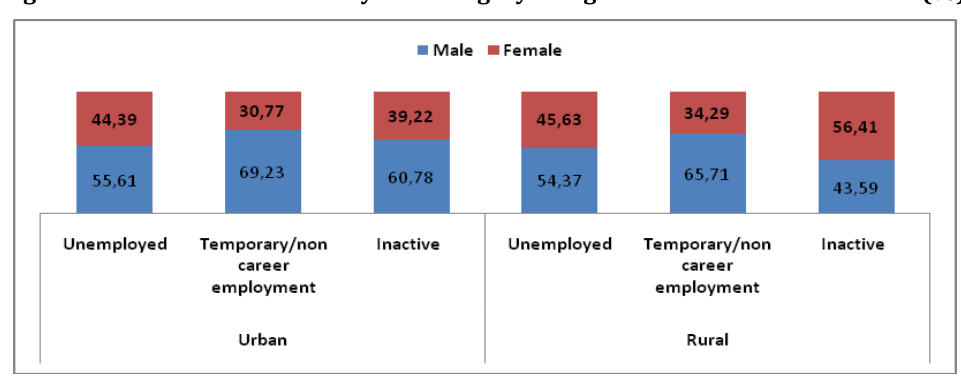
Source : TLMPS 2014 and authors’